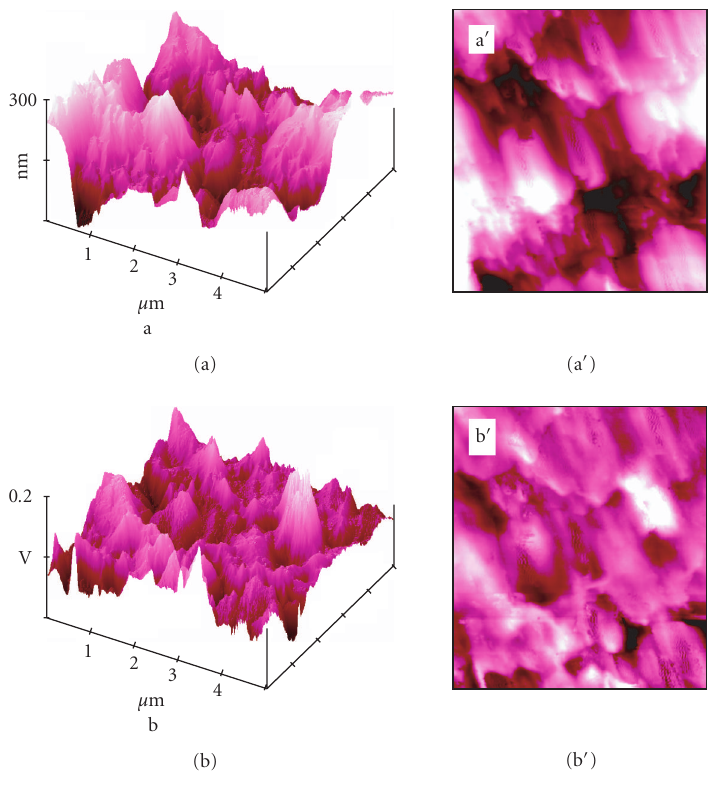
Figure 34: Shear-force AFM (a), (a (cid:3) ) and apertureless SNOM (b), (b (cid:3) ) of a less glossy glazed paper showing roughness and distribution of high, medium, and low optical contrast.